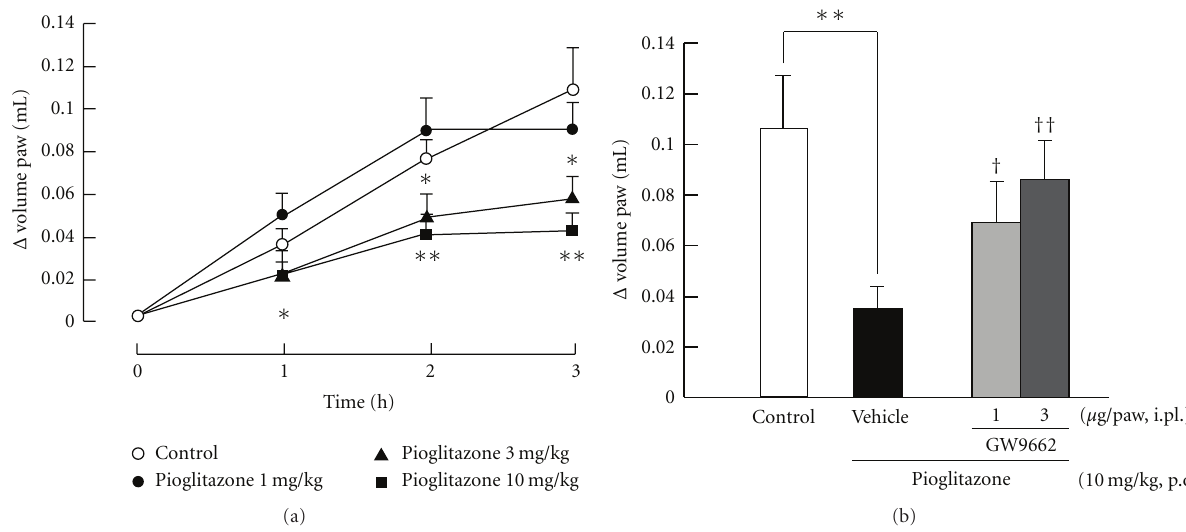
Figure 1: Involvement of PPAR γ on carrageenan-induced paw edema in mice. (a) Dose-dependence and time course of PPAR γ agonist, pioglitazone on carrageenan-induced paw edema in mice. Pioglitazone was orally administrated 3h before carrageenan injection at doses of 1, 3, and 10mg/kg. The control group received 0.5% carboxymethylcellulose. (b) E ff ect of PPAR γ antagonist, GW9662 on pioglitazone induced anti-inflammatory e ff ect. Pioglitazone was orally administrated 3 h before carrageenan injection at a dose of 10 mg/kg. GW9662 was injected 15 min before carrageenan injection at doses of 1 and 3 μ g/paw. The vehicle group received physiological saline including 10% dimethylsulphoxide. Each column and vertical bar represents the means ± S.E.M. ( n = 7). ∗ , ∗∗ : Significantly di ff erent from the control group at P < 0 . 05 and P < 0 . 01, respectively, (Dunnett’s test). † , †† : Significantly di ff erent from the vehicle group at P < 0 . 05 and P < 0 . 01, respectively, (Dunnett’s test).